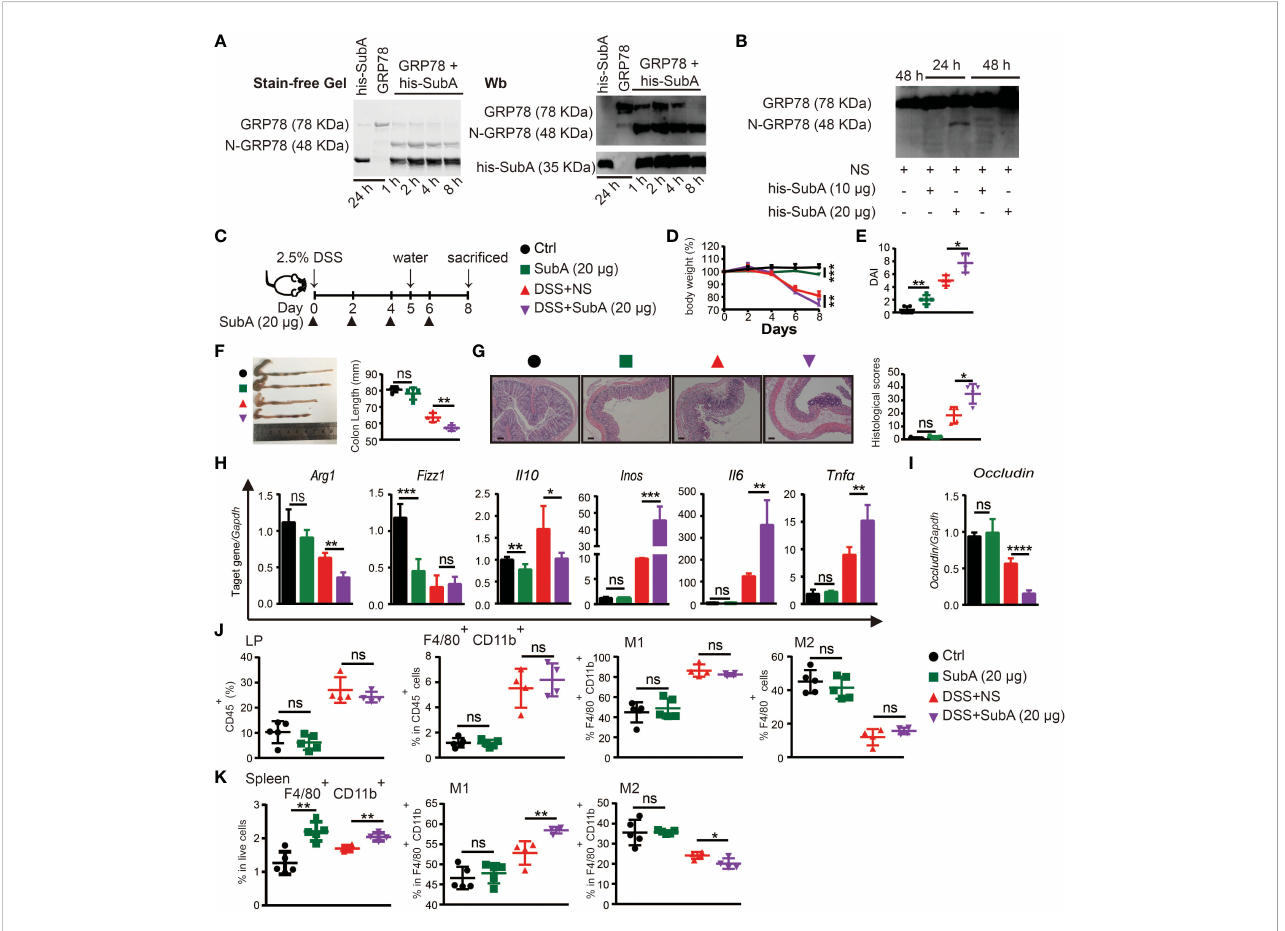
FIGURE 7 Degradation of sGRP78 aggravates DSS-induced colitis. (A) In vitro cleavage of sGRP78 (20 m g/ml) by its selective serine proteinase subA. (B) Cleavage of endogenous sGRP78 by intraperitoneally injected subA. (C) Timetable scheme showing DSS and subA administration in mice and symbols of each group (Ctrl group: black circle; subA group: green square; DSS+NS group: red regular triangle; DSS+subA group: Purple inverted triangle). (D) Weight loss. (E) DAI and (F) representative gross picture of colons (left) and quanti fi cation of colon length (right). (G) Representative HE-stained colons and respective colitis scores of indicated groups. Scale bar: 100 m m. (H) mRNA expression of polarization-related genes in colonic tissues. (I) Colonic expression of Occludin measured by RT-qPCR. Frequencies of CD80 + (M1) or CD206 + (M2) cells in F4/80 + colonic LPLs (J) and spleen (K) . Data represent mean ± SEM (n=4-5). ns, not signi fi cant. * p < 0.05, ** p < 0.01, *** p < 0.001, **** p <